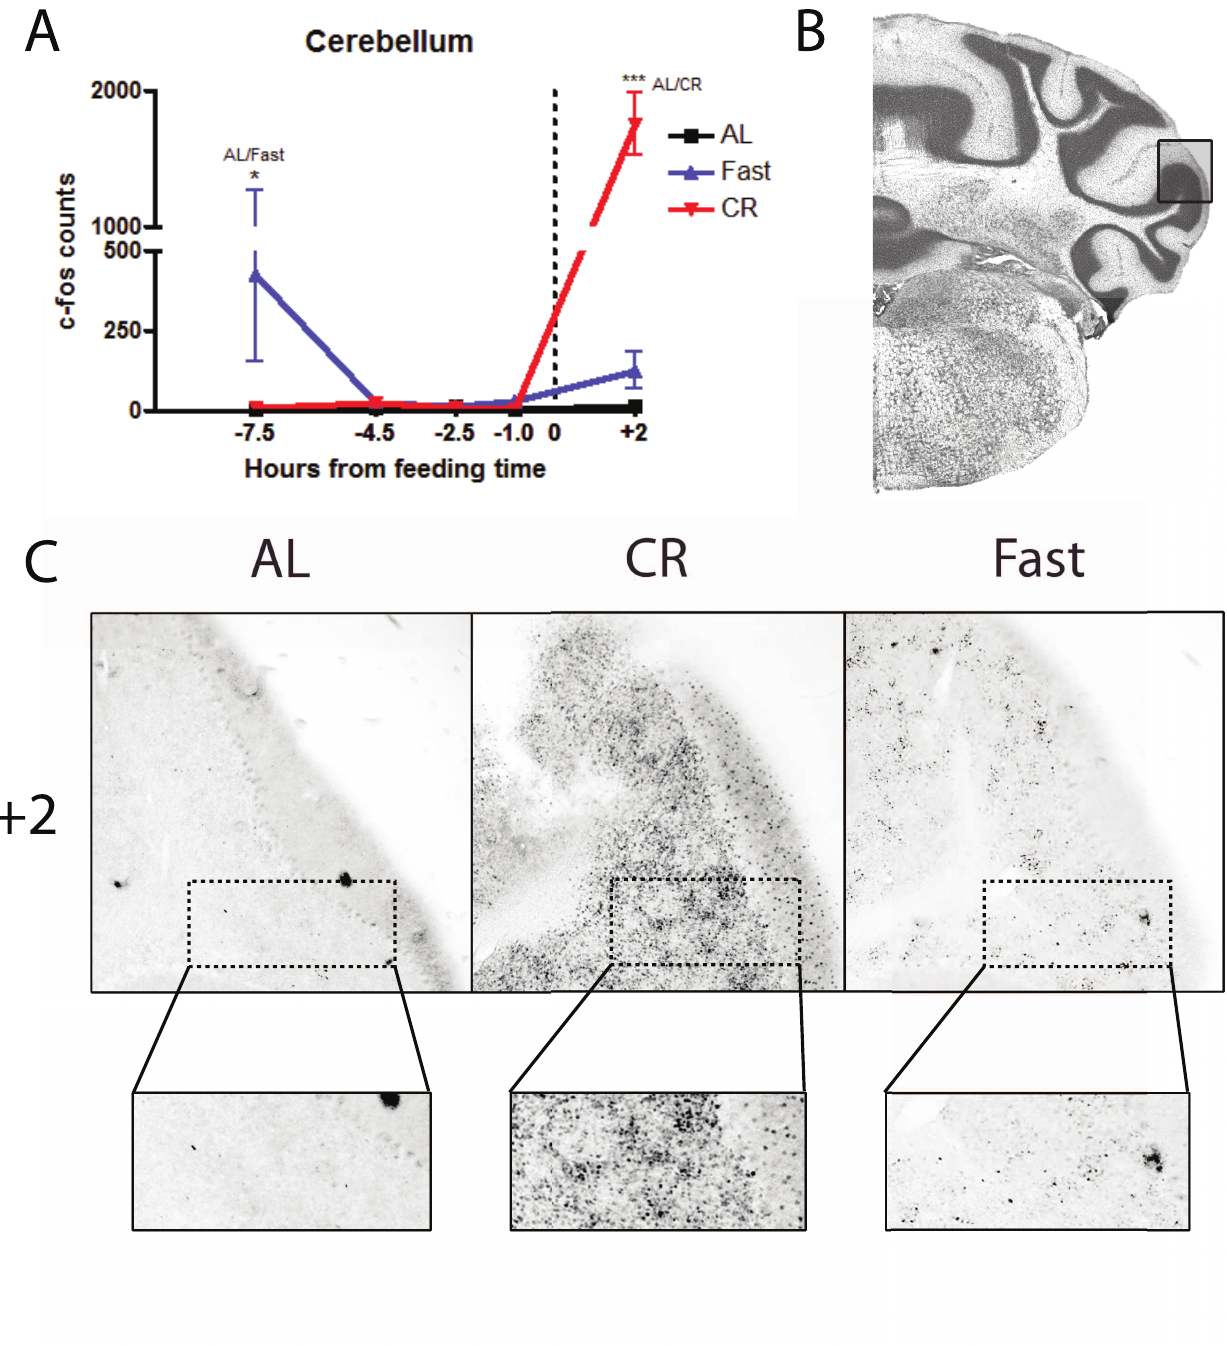
Figure 8. c-Fos protein expression in the in the ansiform lobule crus 2 of the cerebellum of calorie-restricted mice, acutely fasted, and AL control mice. (A) Mean ( 6 SEM) number of c-Fos-immunoreactive nuclei in the NAc Core of AL controls, fasted and CR mice at 5 time points measured relative to feeding. CR mice show a prodigious increase (p , 0.001) in FOS protein expression at TP + 2 (note the split y-axis). Fasted show significant induction of FOS protein at TP 2 7.5 (p , 0.05). AL control mice do not show any appreciable induction in the expression of FOS protein at any time point. (B) Representative coronal brain map with Nissl stain showing location of the ansiform lobule crus 2 of the Cerebellum adapted from Paxinos and Franklin. (C) Representative micrographs at TP + 2 of FOS expression. Insets show high magnifications of c-Fos labeling in the lobule. Sample sizes for TP 2 7.5 thru + 2 are n=6, 15, 10, 8, 3 for AL groups, n=6, 12, 12, 9, 6 for CR groups, and n=3, 5, 5, 5, 3 for Fast groups.